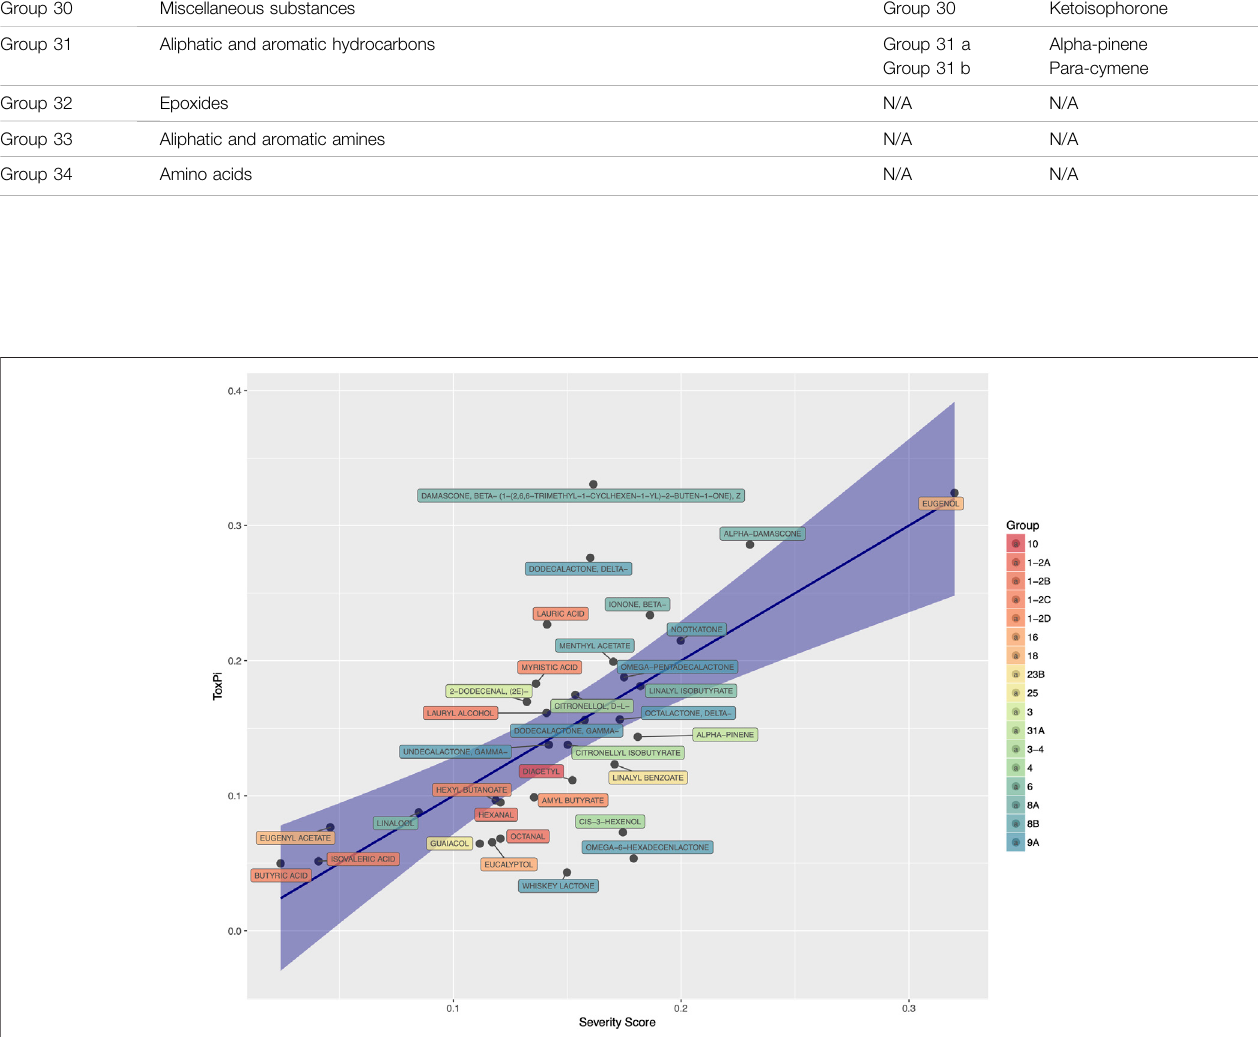
FIGURE 5 | Predicted ToxPi index (Called Severity Score) as predicted by the slected regression model vs . experimental ToxPi index. The R value of this model is 0.67. FGRs are colored by chemical groups.